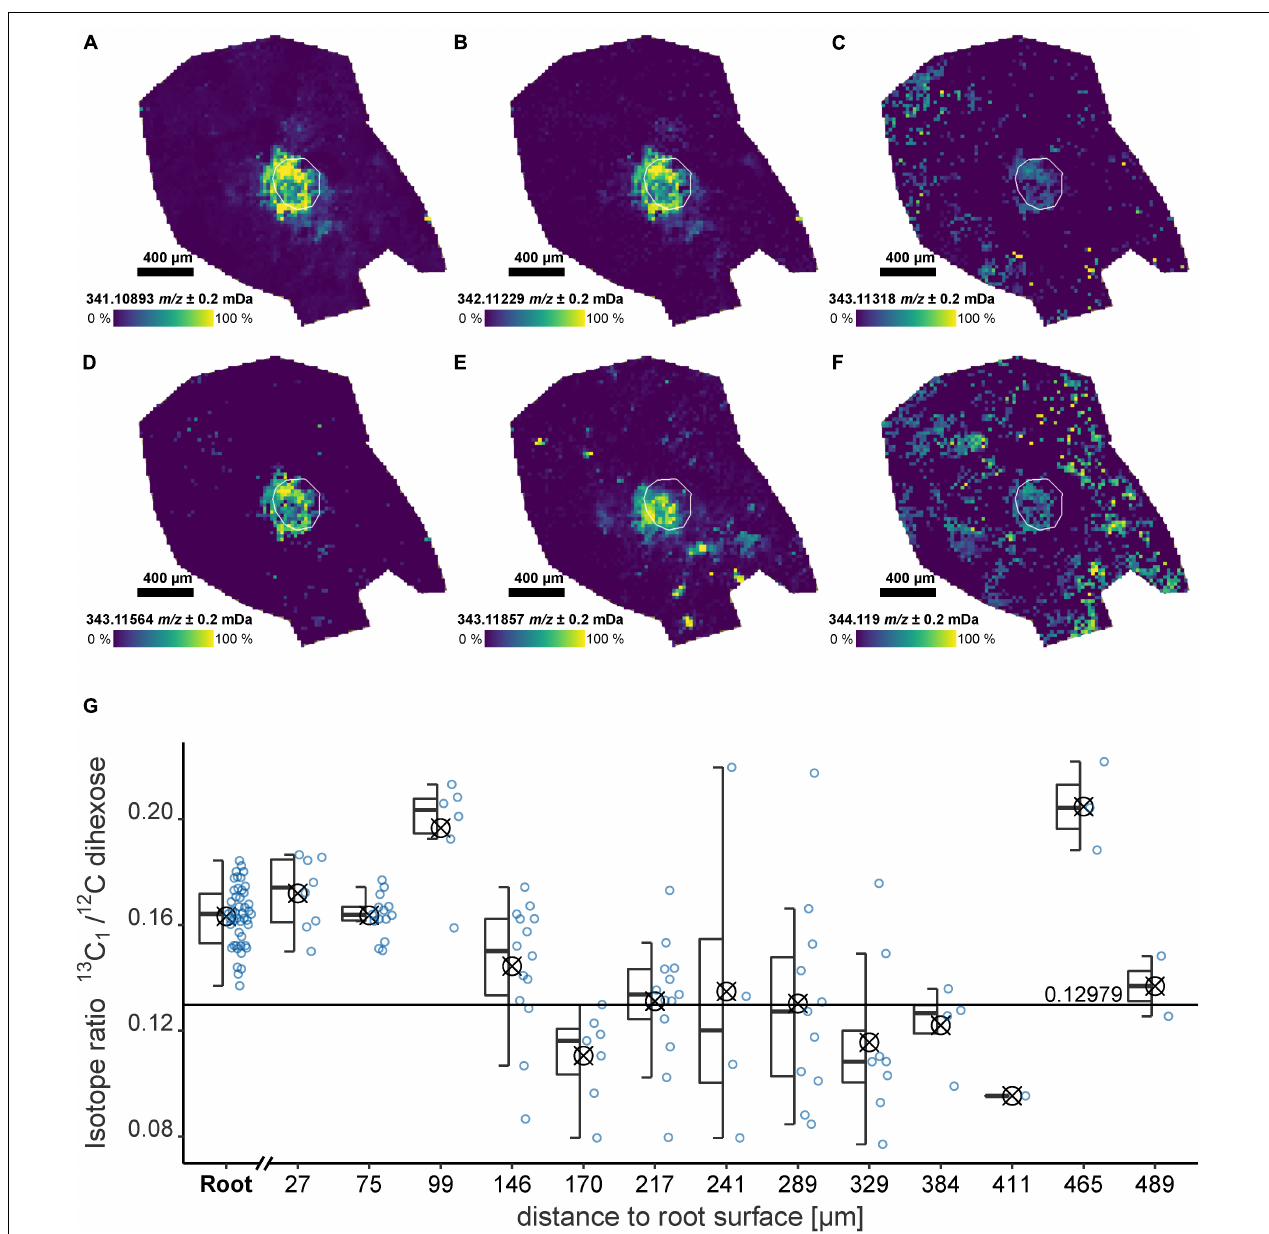
FIGURE 4 | Dihexose Isotopologue and isotope ratio for an undisturbed soil sample from the field experiment (FP1) after 13 C pulse labeling as detected by LDI-FT-ICR-MSI. (A–F) Ion images for Isotopologue signals of the dihexose [C 12 H 22 O 11 − H] − . The root surface is highlighted in white. (A) Monoisotopic signal [ 12 C 121 H 2216 O 11 − H] − , (B) 13 C 1 , (C) 18 O 1 , (D) 13 C 2 , (E) 13 C 12 H 1 , (F) 13 C 3 , and (G) Isotope ratio for regions versus maximum distance to the root surface considering the 13 C 1 / 12 C ratio of the dihexose [C 12 H 22 O 11 − H] − for all laser spots with detectable 13 C 1 -Signal (natural abundance: 0.1298). The isotope ratio for each laser spot is shown as a blue circle. The areas used to construct the boxplots (symbol indicates arithmetic mean) are highlighted in the ion image in Figure 1A